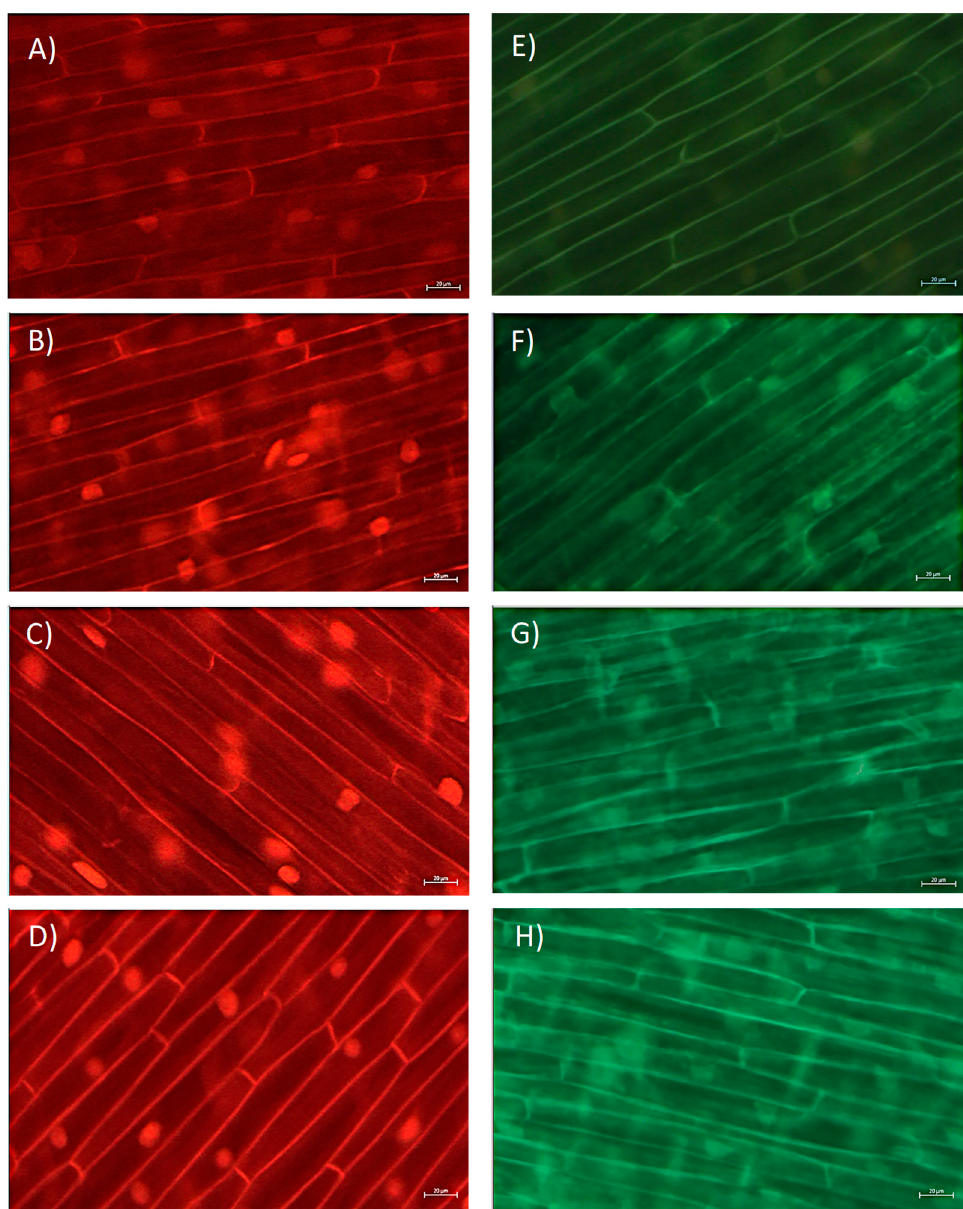
Figure 3. Level of reactive oxygen species (ROS) in situ in root cells of Allium cepa exposed to bisphenol A (BPA) in concentration range 1–10 mg L − 1 for 3 days. Representative fluorescence images of level of: ( A – D ) superoxide radical (O 2 − ) and ( E – H ) hydrogen peroxide (H 2 O 2 ) in root cells. ( A , E ) control; ( B , F ) exposure to 1 mg L − 1 ; ( C , G ) 5 mg L − 1 ; and ( D , H ) 10 mg L − 1 of BPA. Scale bar: 20 µm.